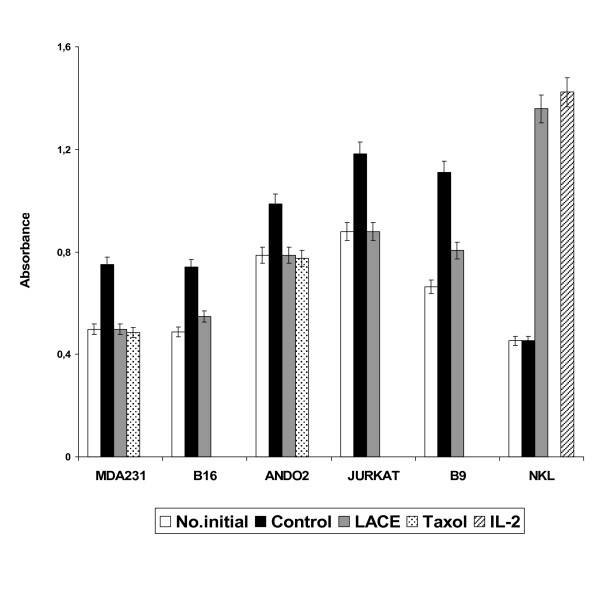
Effect of LACE in proliferation of different cancer cell lines. The MDA MB231, B16, ANDO-2, JURKAT, B9 and NKL tumor cell lines were treated or not with 250 μg/ml of LACE for 72–96 h. MDA MB231 and ANDO-2 were also treated with Taxol. Each column represents the mean of five independent experiments ± SD.